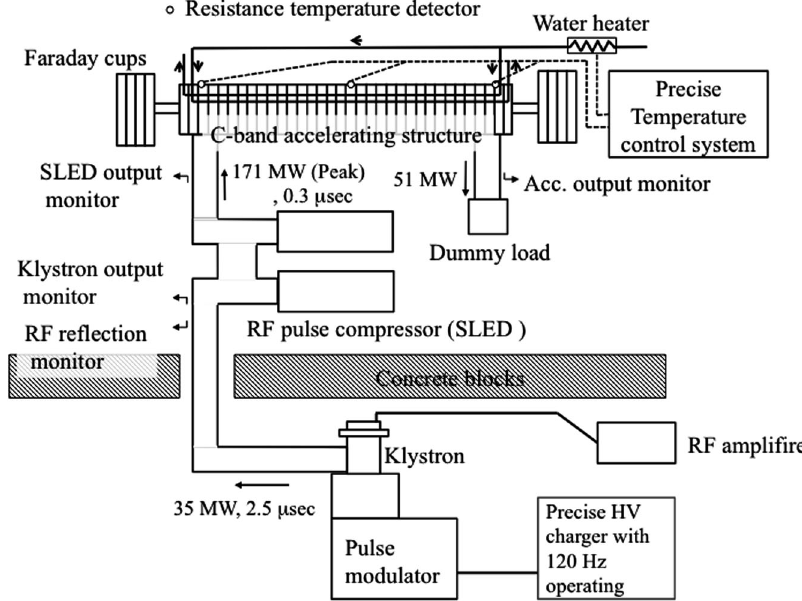
FIG. 9. Schematic diagram of the experimental setup for the high-power rf test of the accelerating structure.